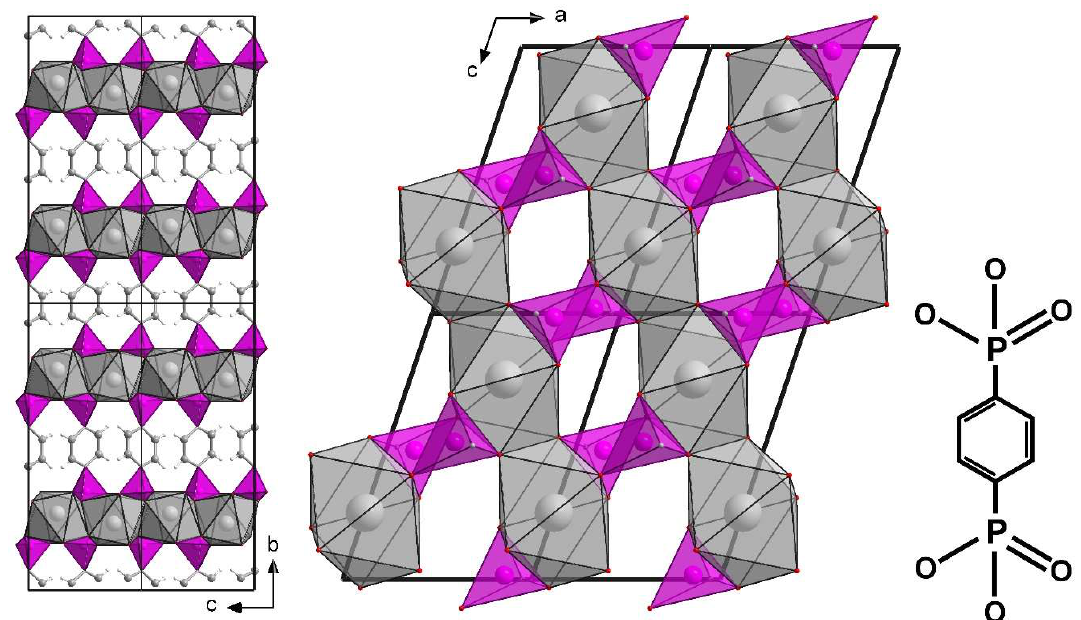
Figure 2. Crystal structure of 1,4-phenylenebis(phosphonate) Ce(III) with the Cambridge Structural Database (CSD) reference code MAXFEY consisting of 2D layers that are connected by the linker [34]. From the side view along the a direction, the crystal structure is similar to ICR-9. However, the coordination of Ce(III) (grey polyhedra) by oxygen atoms as well as its arrangement in the 2D layer are different in comparison with octahedral coordination and honeycomb arrangement of Ce(III) in ICR-9. The tetrahedral environment of phosphorus atoms is depicted by magenta polyhedra. The schematic representation of the linker is in the bottom right corner.